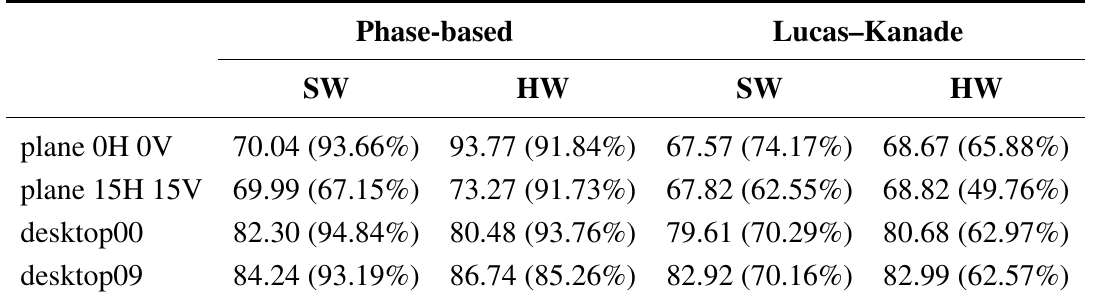
Table 3. Vector disparity performances: PoGP(%), defined as the percentage of pixels where AAE < 5 deg. and the density between